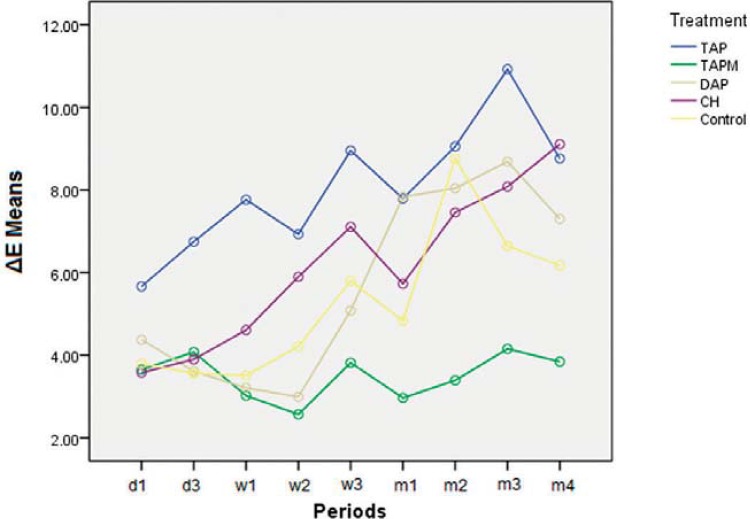
Graphic illustrating ΔE means from each group and period throughout Phase 1